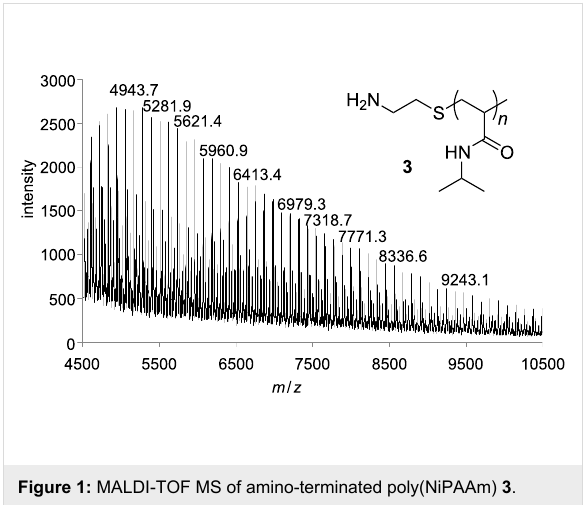
Figure 1: MALDI-TOF MS of amino-terminated poly(NiPAAm) 3